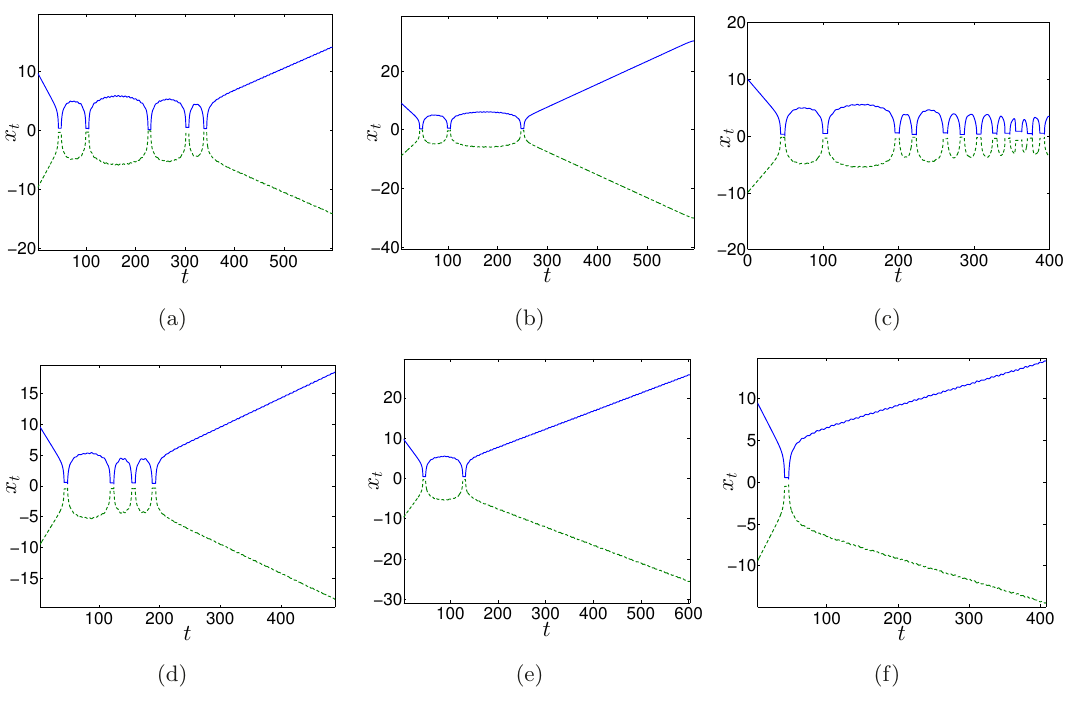
Figure 6 . Kink-antikink collisions when ǫ = 1. (a) A 5-bounce solution at v in = 0 . 154761850. (b) A 3-bounce solution at v in = 0 . 154818. (c) Capture at v in = 0 . 155. (d) A 4-bounce solution at v in = 0 . 1598265. (e) A 2-bounce solution at v in = 0 . 16081. (f) A 1-bounce solution at v in = 0 . 1665.